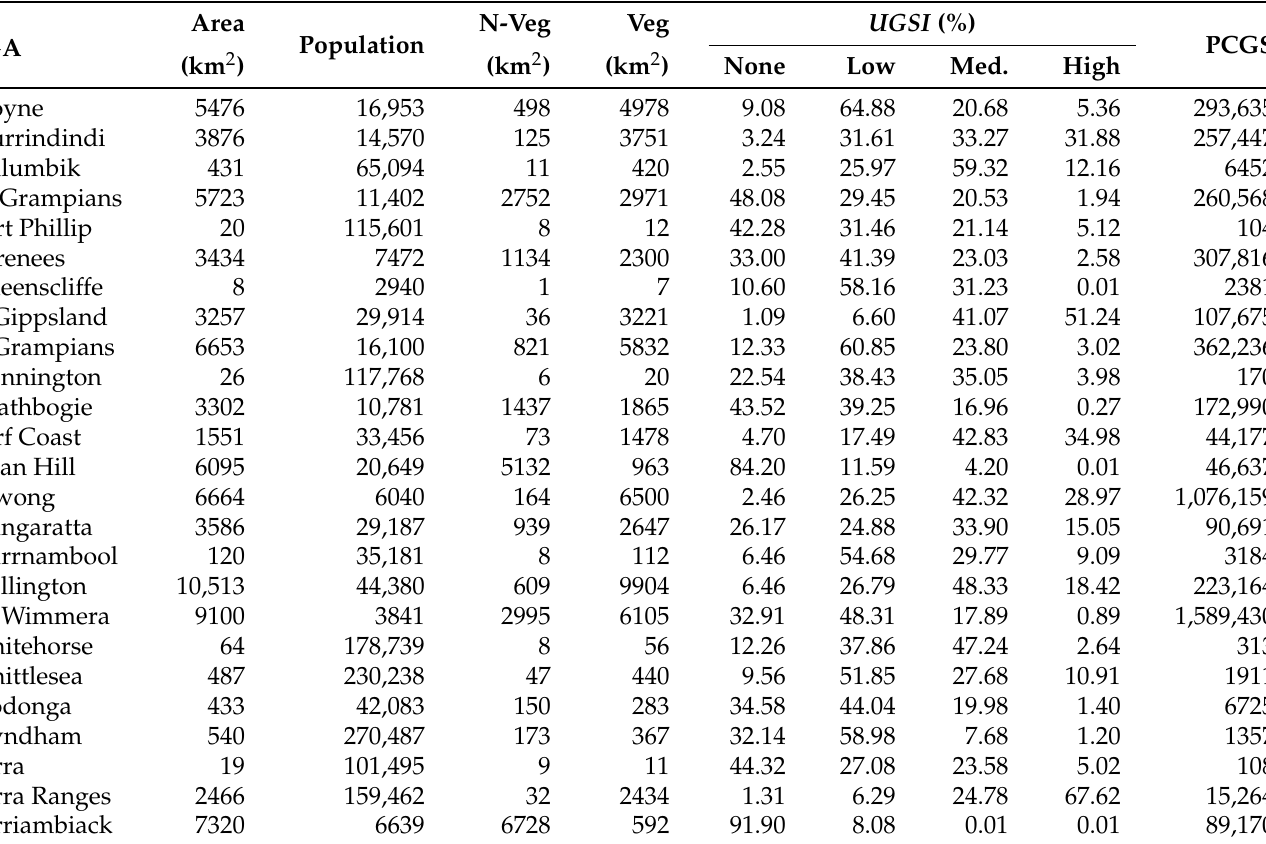
Table 13. Urban Green Space Index ( UGSI ) and Per Capita Green Space ( PCGS ) calculation of different LGAs of Victoria, Australia. Note that the unit of PCGS is m 2